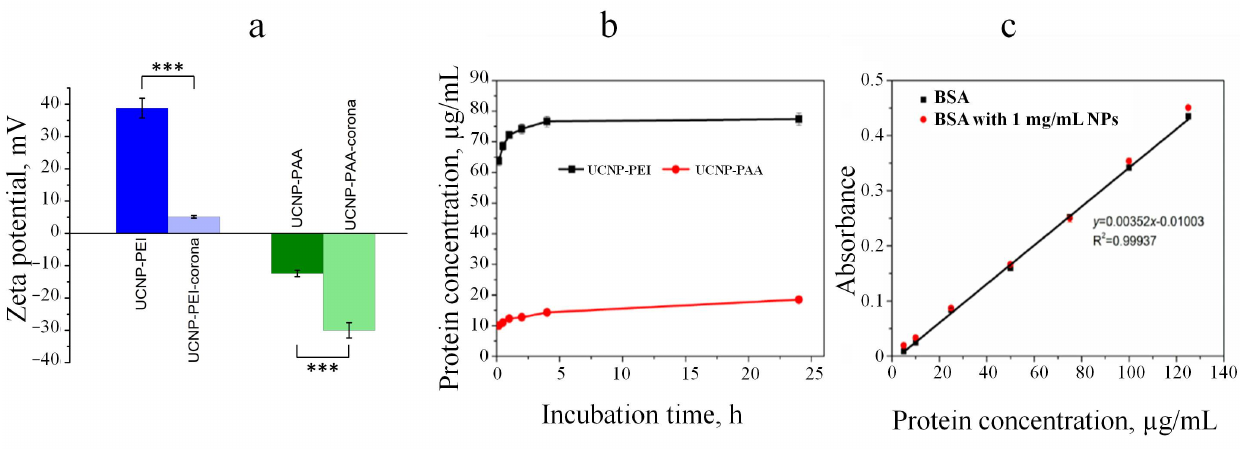
Figure 2. Zeta-potential measurement of polymer-coated UCNPs before and after protein corona formation ( a ). The amount of protein adsorbed on UCNP-PEI and UCNP-PAA after incubation with complete cell culture medium sampled at several timepoints quantified by BCA assay ( b ). Each value represents the mean ± standard deviation of 5 replicates. Standard absorbance–concentration curves for BSA in the presence and absence of 1 mg/mL UCNP-PAA ( c ). Statistical significance was designated with *** p <